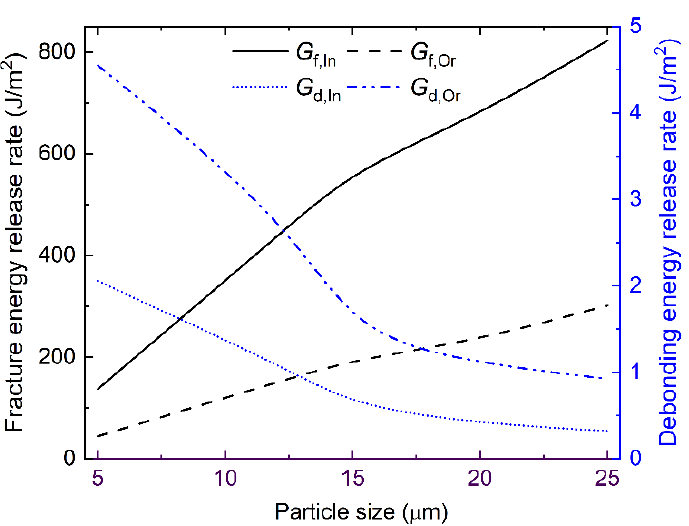
Figure 9. Fracture and debonding energy release rate of the inorganic and organic SEI layers as a function of particle size.